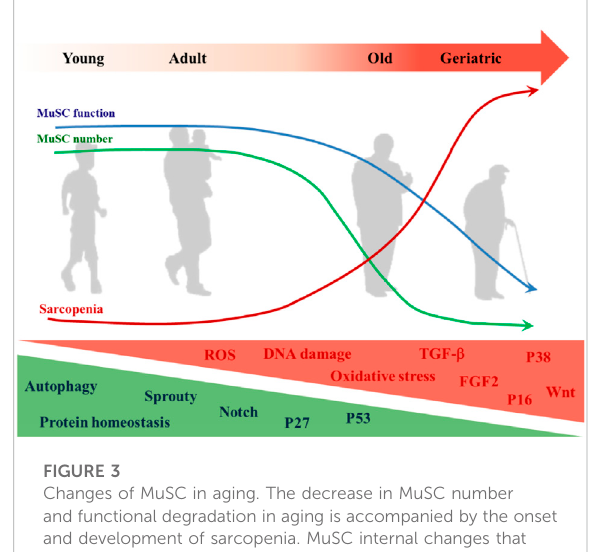
FIGURE 3 Changes of MuSC in aging. The decrease in MuSC number and functional degradation in aging is accompanied by the onset and development of sarcopenia. MuSC internal changes that increase with aging include but are not limited to: ROS, DNA damage, oxidative stress, expressions of TGF- β , FGF2, p38, p16 Ink4 , and Wnt signaling pathway. Those that decrease with aging include but are not limited to: autophagy, protein homeostasis, expressions of Sprouty, p27 Kip1 , p53, and notch signaling